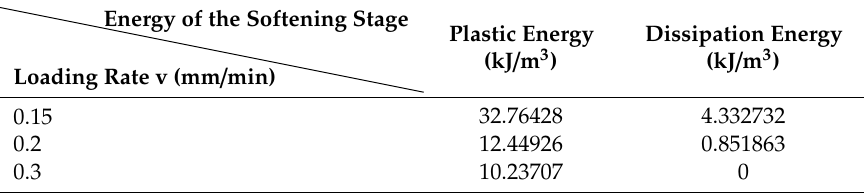
Table 4. Plastic energy and dissipation energy of the softening stage under di ff erent loading